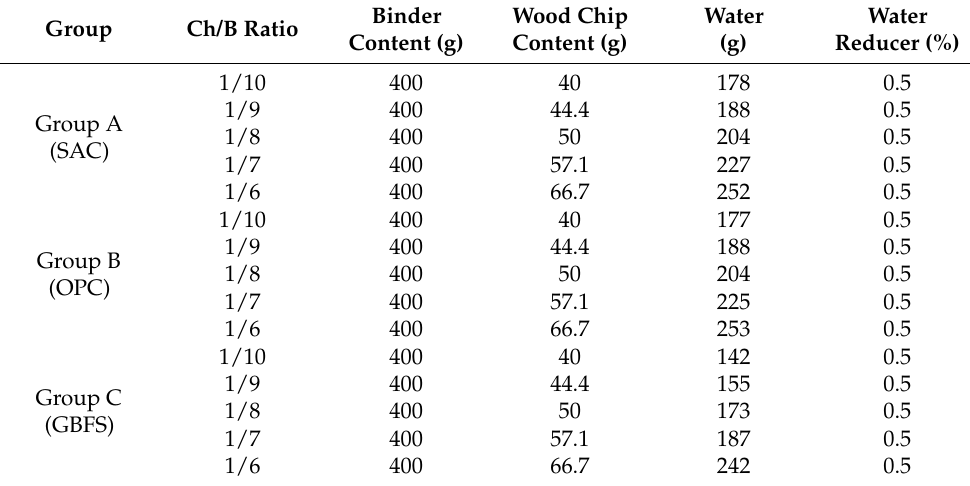
Table 4. Mix proportion design of the